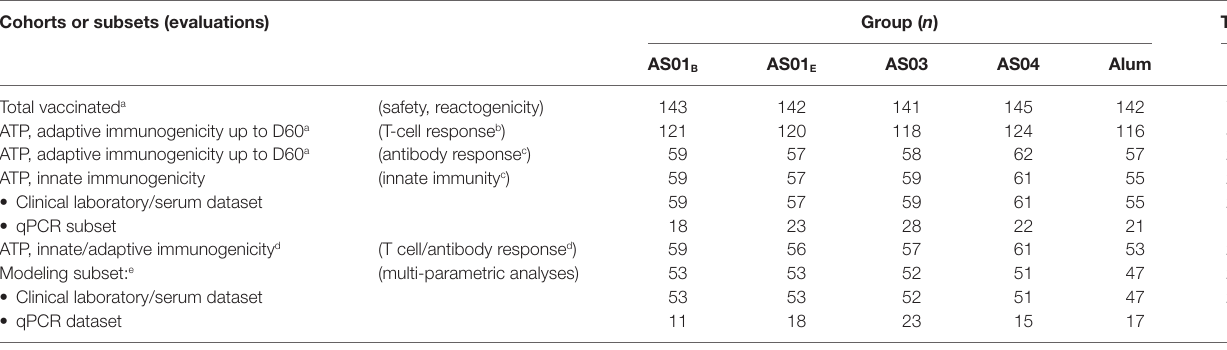
TablE 1 | Cohorts and subsets. Cohorts or subsets (evaluations) Group ( n )